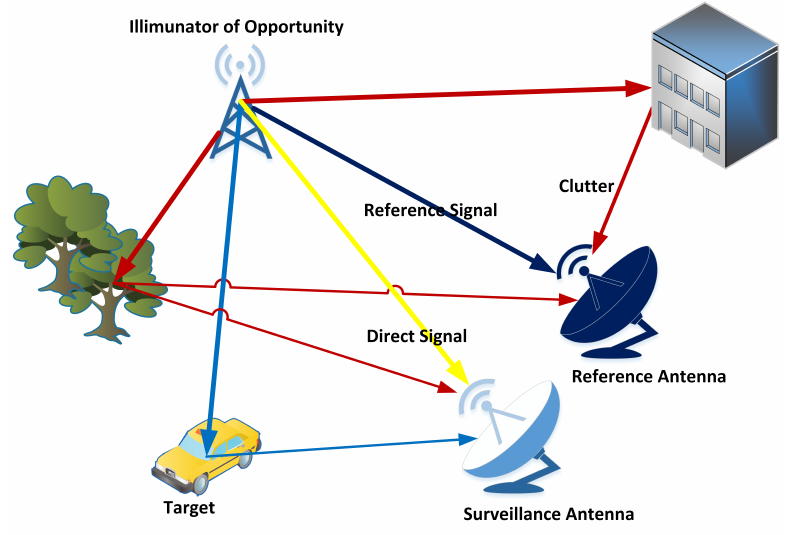
Figure 1. A common scenario for passive radar